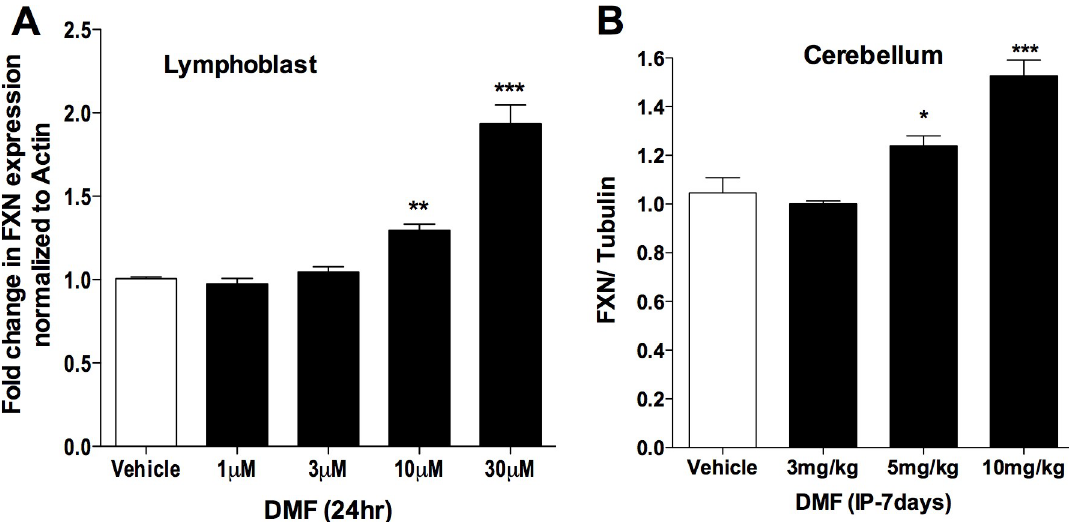
Fig 1. DMF dose dependently increases FXN expression in vitro in various patient derived lymphoblast cell models and in vivo in YG8 mice model of FA. (A) Lymphoblast cells (GM14518, GM15850, GM16214, GM16216 and GM16220) were treated with 0.01% DMSO vehicle, 1,3,10 or 30 μ M DMF for 24hr. RNA was extracted and FXN expression was measured by qRT-PCR as FXN normalized to Actin. Vehicle, n = 50; 1 μ M, n = 3; 3 μ M, n = 20; 10 μ M, n = 24; 30 μ M, n = 42. (B) Mice were IP dosed with 3,5 and 10 mg/kg DMF for 7 day. Protein was extracted from Cerebellar tissue and measured using Western Blot analysis as Frataxin normalized to Tubulin or Actin. (n = 4; each group). Bars represent averages ± standard deviations (p < 0.05 � , p < 0.01 �� , p < 0.001 ��� ).